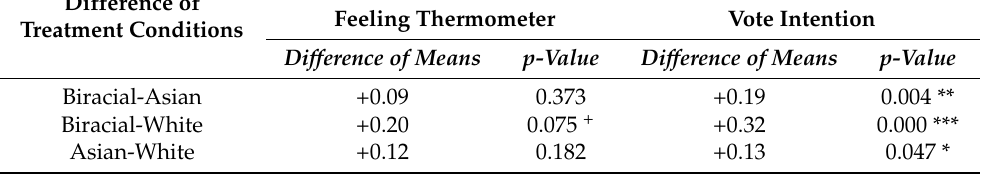
Table 3. Results from difference-of-means t -tests for all possible treatment group comparisons in Figure 3. Asian-White-Identified Participants Difference of Feeling Thermometer Vote Intention Treatment Conditions Difference of Means p-Value Difference of Means p-Value Biracial-Asian +0.02 0.786 +0.06 0.315 Biracial-White +0.17 0.054 + +0.19 0.012 ** Black-White-Identified Participants Difference of Feeling Thermometer Vote Intention Treatment Conditions Difference of Means p-Value Difference of Means p-Value